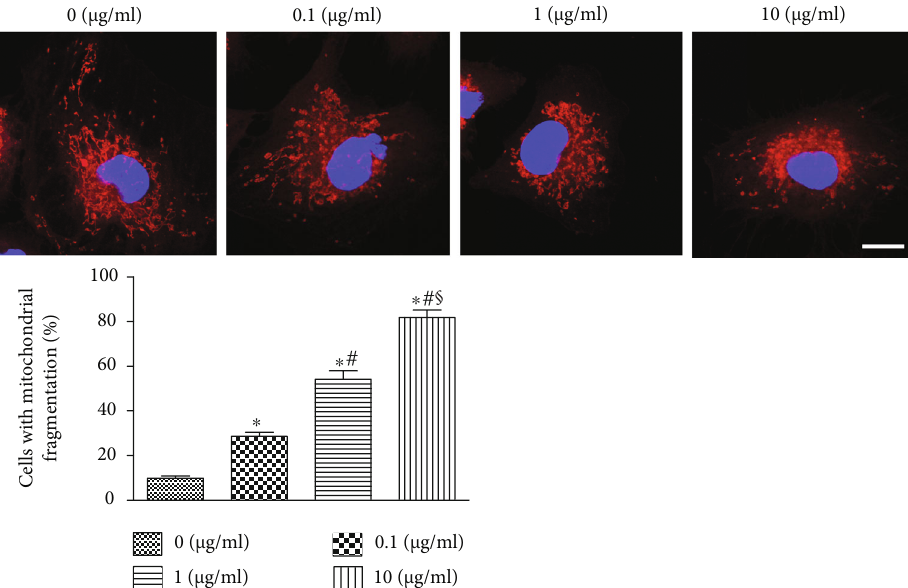
Figure 6: Mitochondrial damage in HK-2 cells challenged by HMGB1. The confocal microscope shows mitochondria stained with MitoTracker Red. The proportion of cells with mitochondrial fragmentation was evaluated. Scale bars 10 μ m. ∗ P < 0 : 05 compared with the 0 μ g/mL group; # P < 0 : 05 compared with the 0.1 μ g/mL group; § P < 0 : 05 compared with the 1 μ g/mL